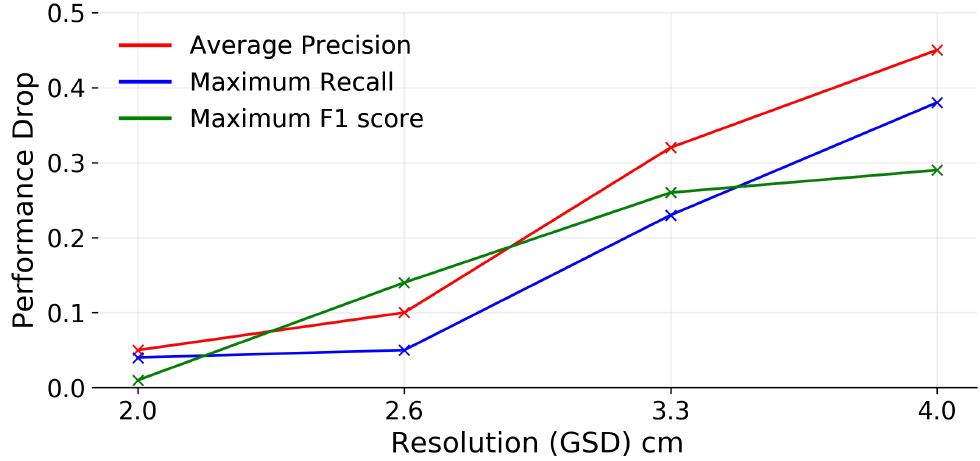
Figure 5. Detection performance degradation due to flying faster at various altitudes. This shows the absolute difference between each performance metric at a slow flying speed and the same performance metric at faster flying